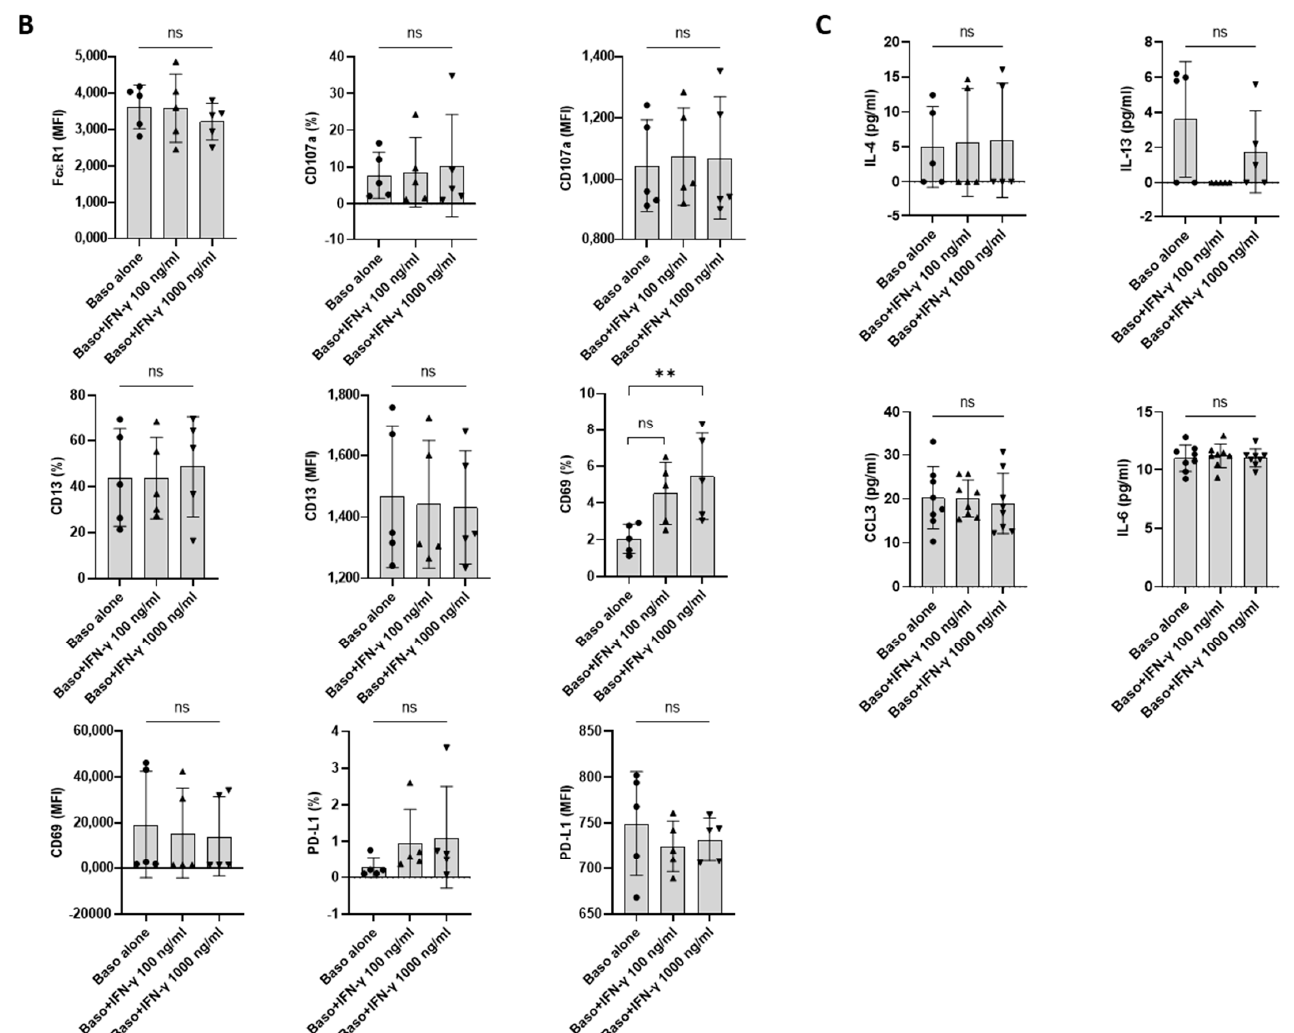
Figure 1. The effect of IFN- γ on the expression of PD-L1 in primary human basophils. Basophils (0.1 × 10 6 cells/200 µ L/96-well plate) isolated from PBMCs of healthy donors were cultured with or without IFN- γ at 100 or 1000 ng/mL. Basophil phenotype was evaluated by flow cytometry after 24 h. ( A ) Dead cells were excluded with the help of fixable viability dye (FVD) and live basophils were gated. Representative histogram overlays displaying the expression pattern of Fc ε RI, CD107a, CD13, CD69, and PD-L1. ( B ) Expression of Fc ε RI, CD107a, CD13, CD69, and PD-L1 on the basophils (% positive cells and median fluorescence intensities (MFI), mean ± SD; n = 5 independent donors with three independent experiments). ( C ) The amount (pg/mL) of secreted IL-4, IL-13, CCL3 and IL-6 in the cell-free supernatant from the above experiments (mean ± SD, n = 5 to 8 independent donors from three independent experiments). ns, not significant, ** p < 0.01, one-way ANOVA Friedman